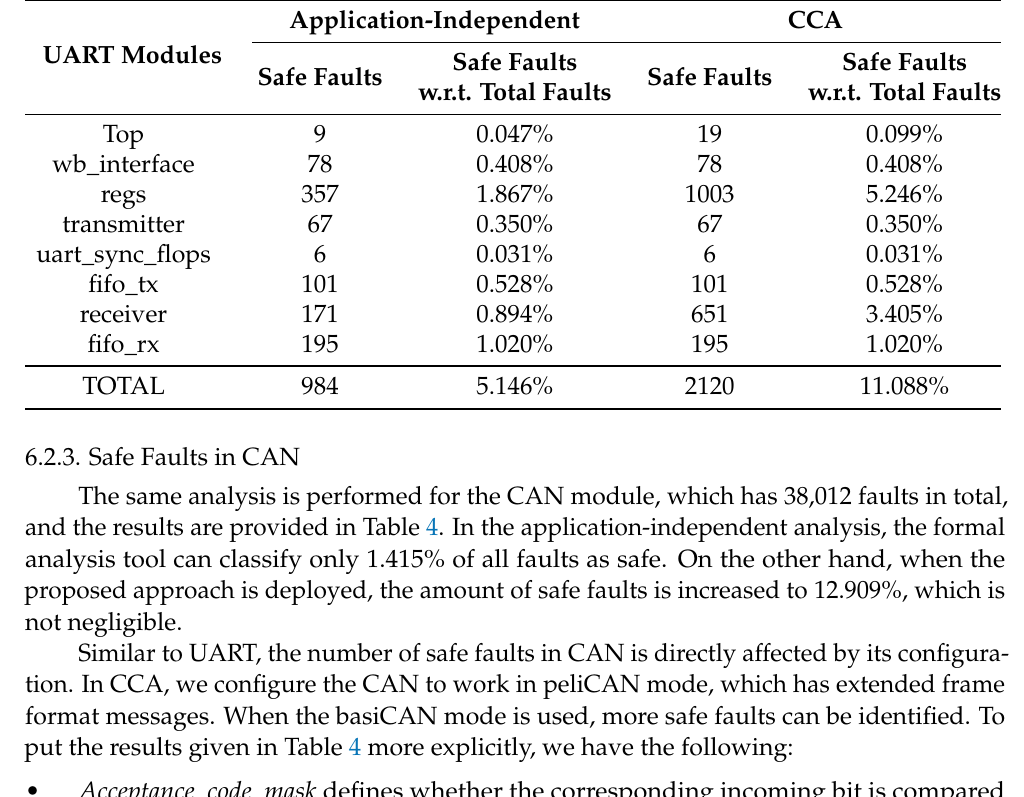
Table 3. Safe faults in the UART